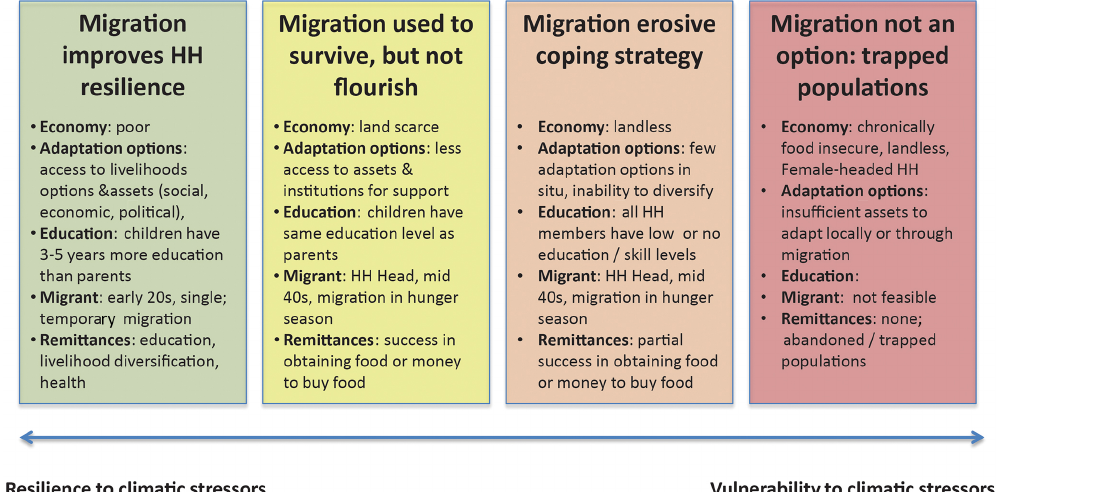
Figure 5. Household (HH) profiles affect whether migration is adaptive or erosive vis-à-vis rainfall, food, and livelihood insecurity. Source: Warner and Afifi (2014) (Fig.